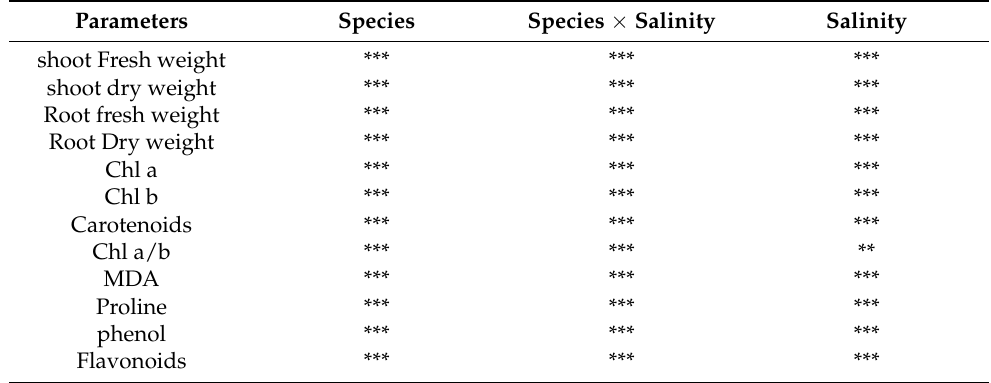
Table 2. Two-way ANOVA of salinity, species, and their interaction on all tested parameters.